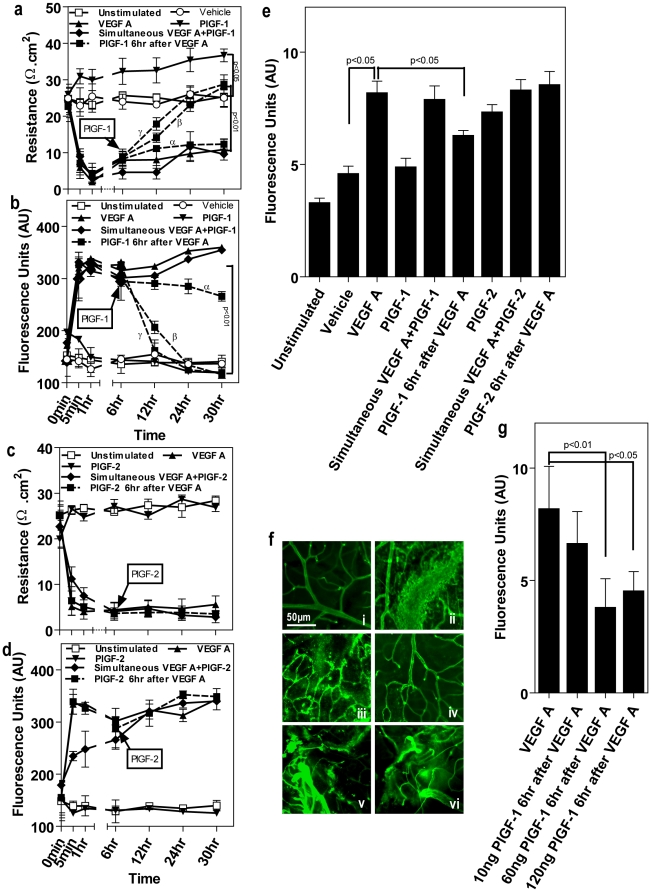
PlGF-1, but not PlGF-2, exerts a temporal-dependent regulation of VEGFA-induced permeability.(a) & (c) Temporal changes in transendothelial resistance across a microvascular endothelial monolayer grown on a Transwell insert with the five conditions including the unstimulated group, vehicle (saline), VEGFA alone, PlGF alone, simultaneous VEGFA + PlGF and PlGF 6 hours post VEGFA (n = 5 independent experiments). VEGFA was used at 100 ng/ml. Data for hPlGF-1 and hPlGF-2 is at 100 ng/ml with the exception of PlGF 6 hours post VEGFA in which results are shown for PlGF at 10 ng/ml (α), 100 ng/ml (β) and 200 nglml (γ). hPlGF-1 was used in (a) and hPlGF-2 in (c). (b) & (d) Show paracellular macromolecular permeability to 40 kDa Dextran-FITC using the conditions described above for (a) and (c) (n = 5 independent experiments). In the case of PlGF 6 hours or 24 hours post VEGF, Transwell inserts were transferred to new wells containing basal medium without fluorescent dextran. (e) Leakage of systemic FITC-labeled albumin into the retina of C57BL/6 mice receiving one of the following intravitreal injections: VEGF; hPlGF-1 or mPlGF-2; VEGF plus hPlGF-1 or mPlGF-2; 0.9% saline vehicle; VEGF followed by hPlGF-1 or mPlGF-2 6 or 24 hours later; VEGF followed by 0.9% saline 6 or 24 hours later. VEGF was given at a concentration of 60 ng/µl while hPlGF-1 and mPlGF-2 were injected at 10, 60 or 120 ng/µl. 46 hours post the first injection mice received tail vein injections of FITC-labeled albumin and retinas were taken for analysis 2 hours later (n = 10-20 per group). (f) Representative confocal microscopy showing dilated vessels and leakage of FITC-labeled albumin in the retinas of mice receiving vehicle only (i), VEGF A (ii), simultaneous VEGF + hPlGF-1 (iii), VEGFA followed by hPlGF-1 6 hours later (iv), simultaneous VEGF + mPlGF-2 (v), or VEGFA followed by mPlGF-2 6 hours later (vi). As shown in (g), PlGF-1 reduced Leakage of systemic FITC-labeled albumin into the retina of C57BL/6 mice receiving intravitreal injection of VEGF A in a dose-dependent manner. Data are represented as means ± s.e.m. *p<0.05, ** by p<0.01 (Student's t test and ANOVA for multiple comparisons). Scale bar  = 50 µM.